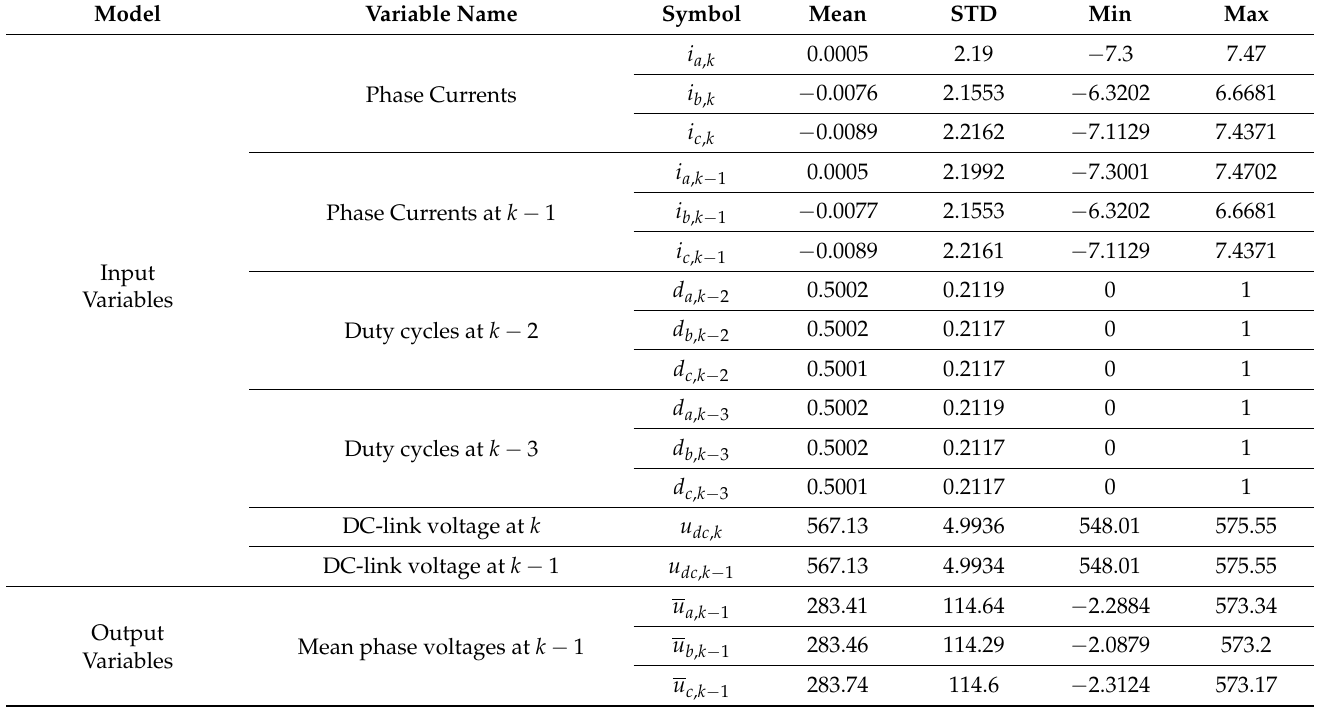
Table 1. Statistical description of the black-box inverter model. (The k refers to sampling step).